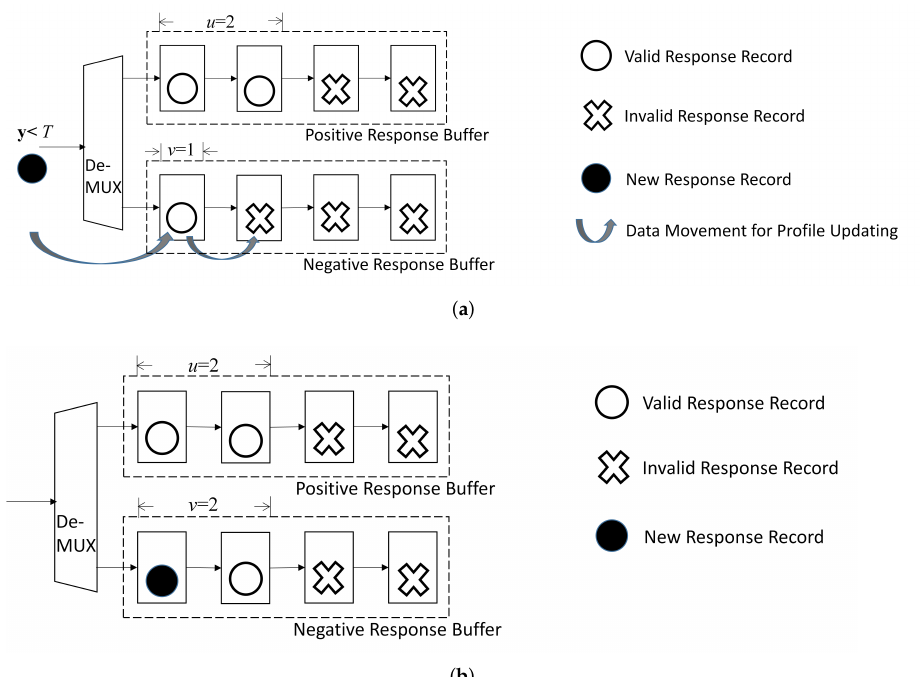
Figure 9. A simple example for updating buffers in profile updating unit for p < C . In this example, C = 4, p = 3, u = 2, and v = 1 before updating. Assume y < T for the new record. The new record is then assigned to negative response buffer. After updating, p = 4, u = 2, and v = 2. ( a ) Before updating; ( b ) After